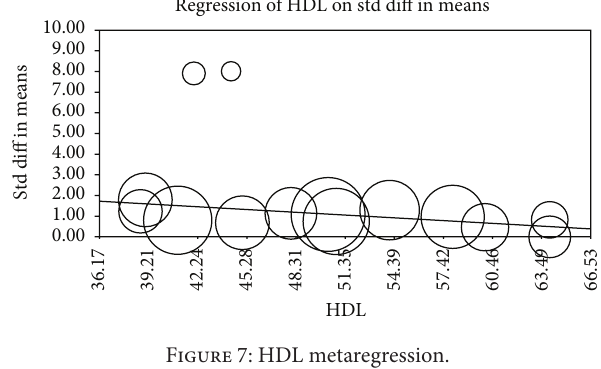
Figure 7: HDL metaregression.